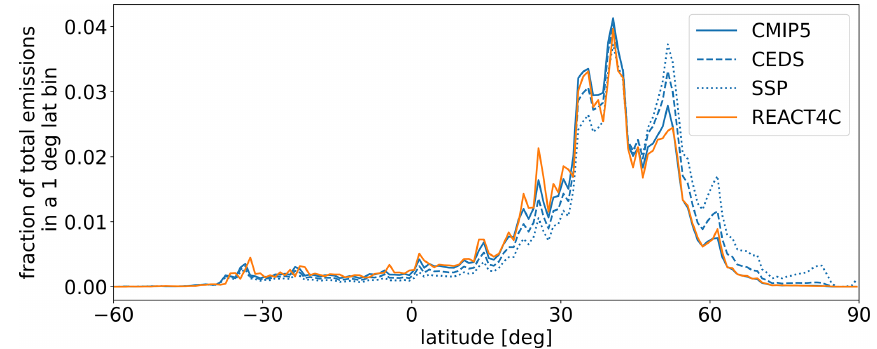
Figure 1. Fraction of total aviation emissions as a function of latitude. The solid blue line is based on the RCP 4.5 scenario for the year 2000 (CMIP5; Lamarque et al., 2010). The dashed blue line is based on historical emissions provided in the CEDS (CMIP6; Hoesly et al., 2018). The dotted blue line is based on the SSP2 4.5 scenario for the year 2015 (CMIP6; Fricko et al., 2017; Gidden et al., 2019). The orange line is based on the REACT4C inventory (Søvde et al.,